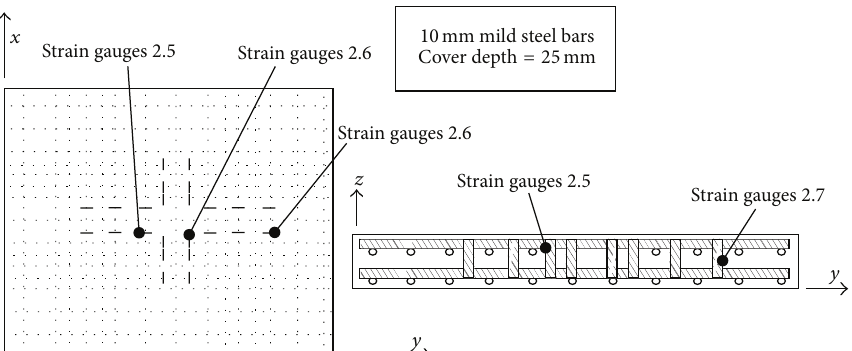
Figure 5: Reinforcement details and location of strain gauges 2.5 to 2.7 in slab S2 (gauges 2.1 to 2.4 are identical to 1.1 to 1.4 in slab S1).